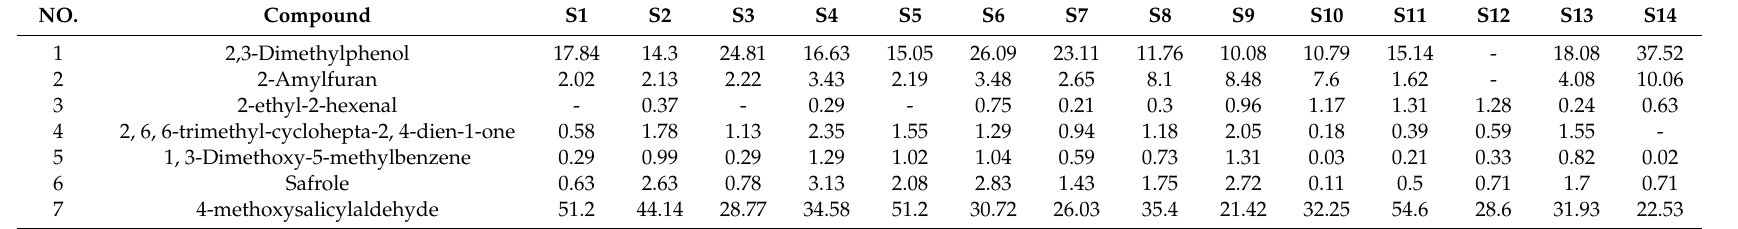
Table 6. The relative content of volatile components in Cortex Periplocae from di ff erent habitats